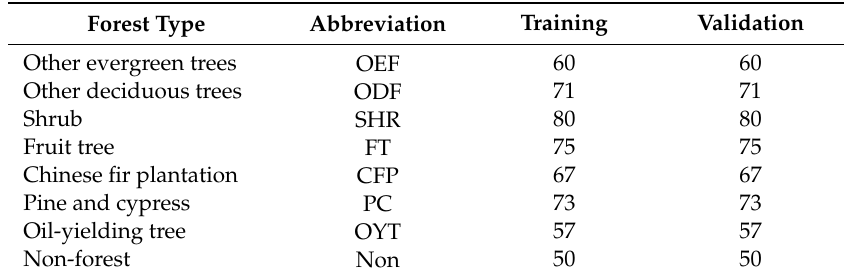
Table 1. Number of training and validation samples for each forest type